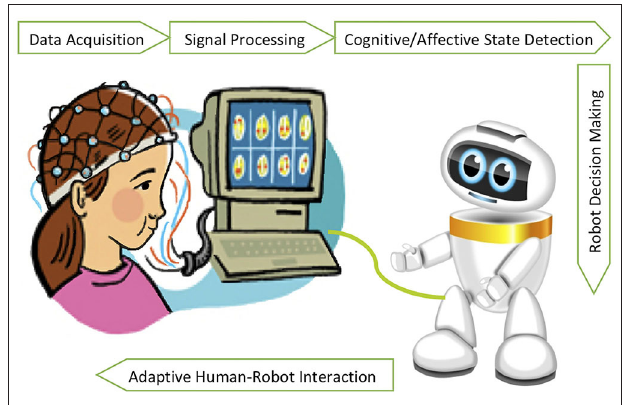
FIGURE 1 | Closed-loop human-robot interaction using passive BCIs.